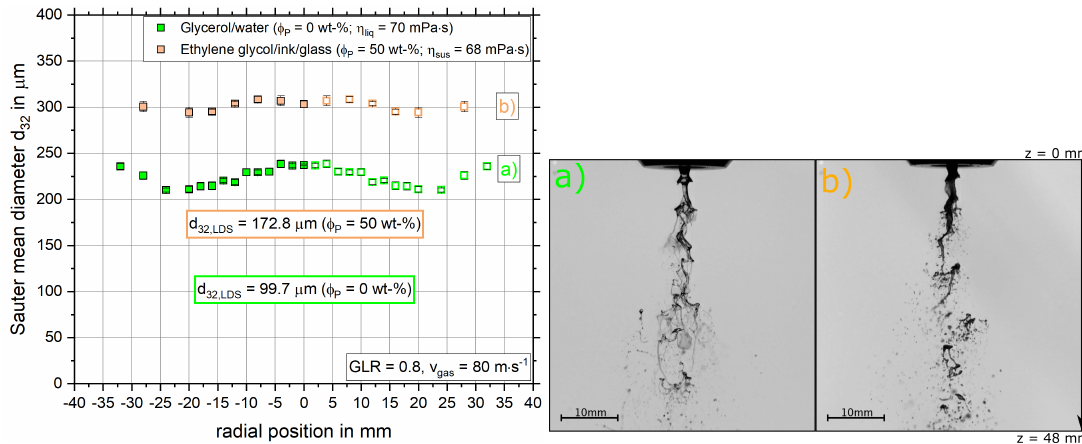
Figure 9. Radial distribution of the Sauter mean diameter at z = 150 mm below the nozzle orifice as a function of the glass mass fraction for v gas = 80 m · s − 1 (dots: SpraySpy R (cid:13) , values: LDS) (left); High-speed camera images of the primary breakup for v gas = 80 m · s − 1 at ( a ) φ P = 0 wt-% and ( b ) φ P = 50 wt-%